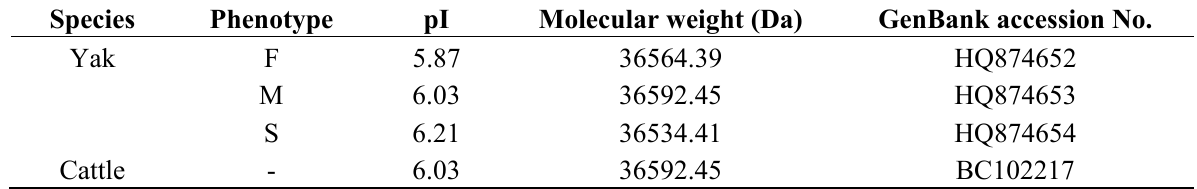
Table 3. Theoretical isoelectric point and molecular weight for H subunit of yak LDH1.